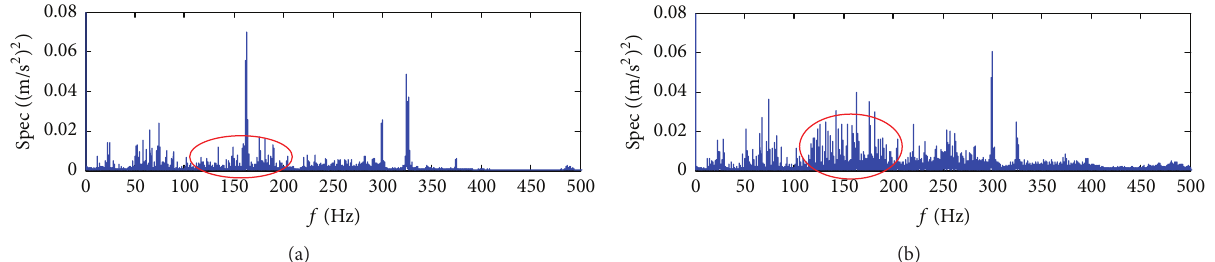
Figure 10: Amplitude spectra of vibration signals in chn08 and chf08. (a) Normal and (b) fault.